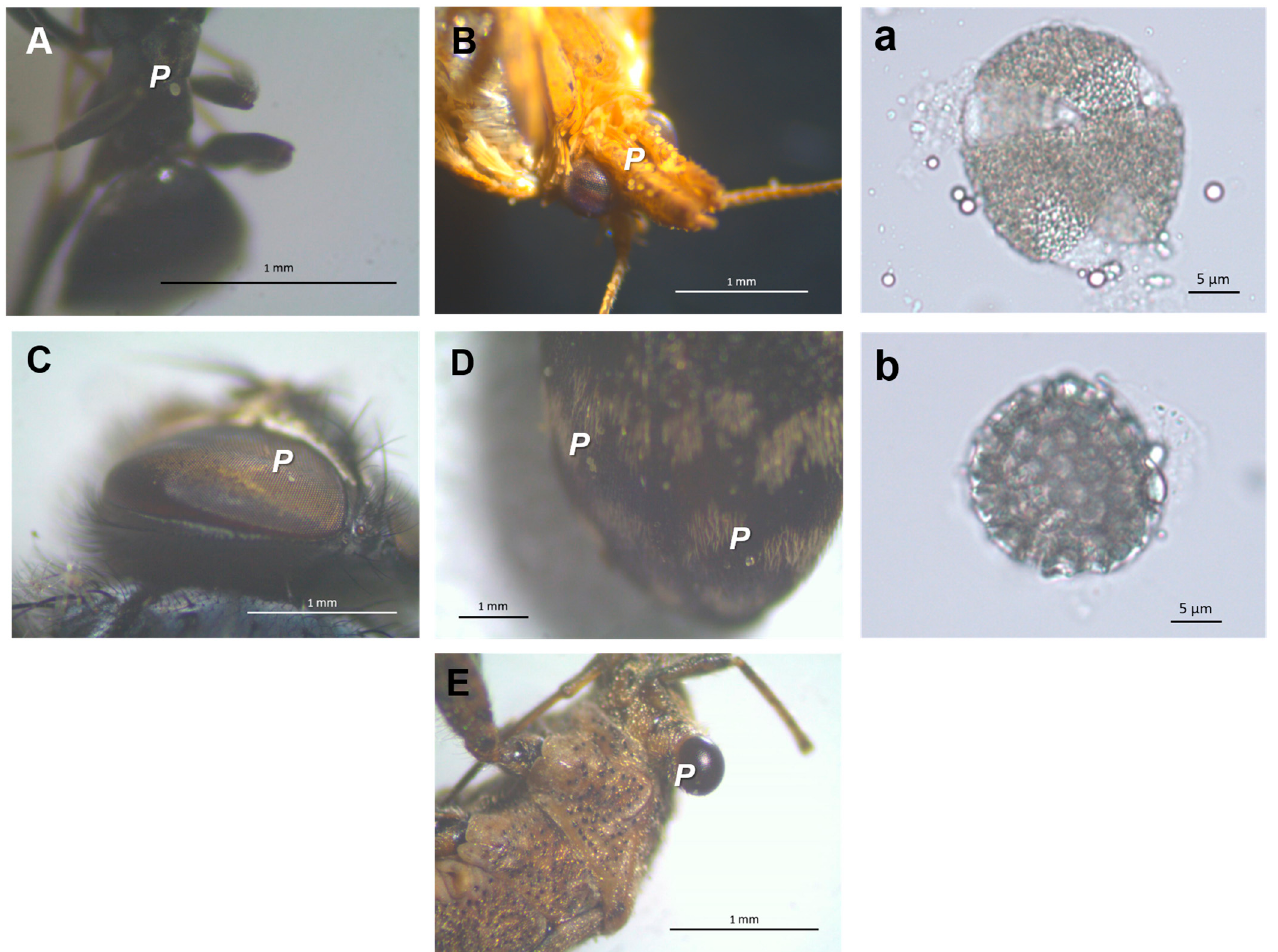
Figure 4. Pollen grains in insect pollinators from the five different orders observed during this study ( A – E ). Some of the pollen grains present on each insect captured are circled in red. ( A ) Tapinoma sp. (70 × ); ( B ) Clepsis coriacana (40 × ); ( C ) Diptera (45 × ); ( D ) Coleoptera (45 × ); ( E ) Heteroptera (45 × ); ( a ) Limonium pollen grain from A ( a , colpi arrowed) or ( B ) ( b )